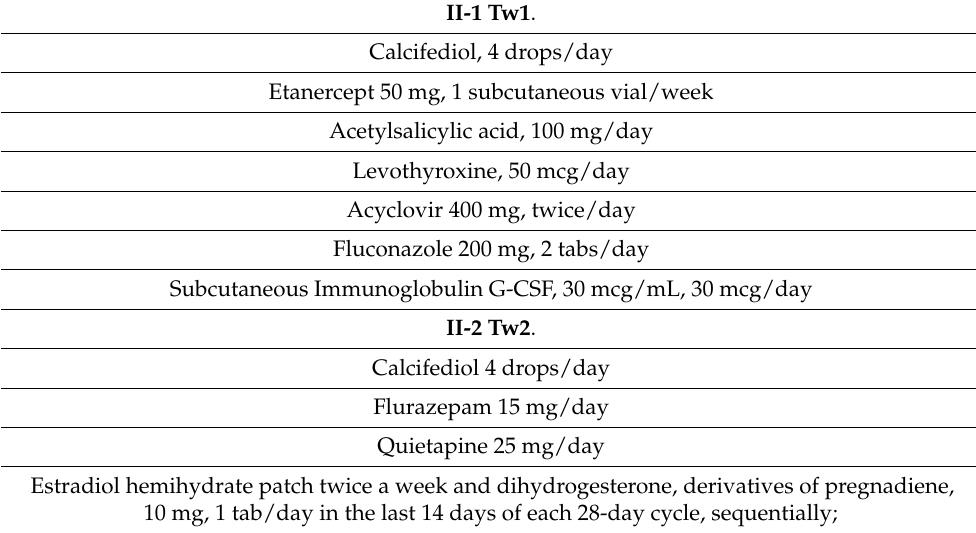
Table 3. Pharmacological therapy in place up to date in II-1 Tw1 and II-2 Tw2.